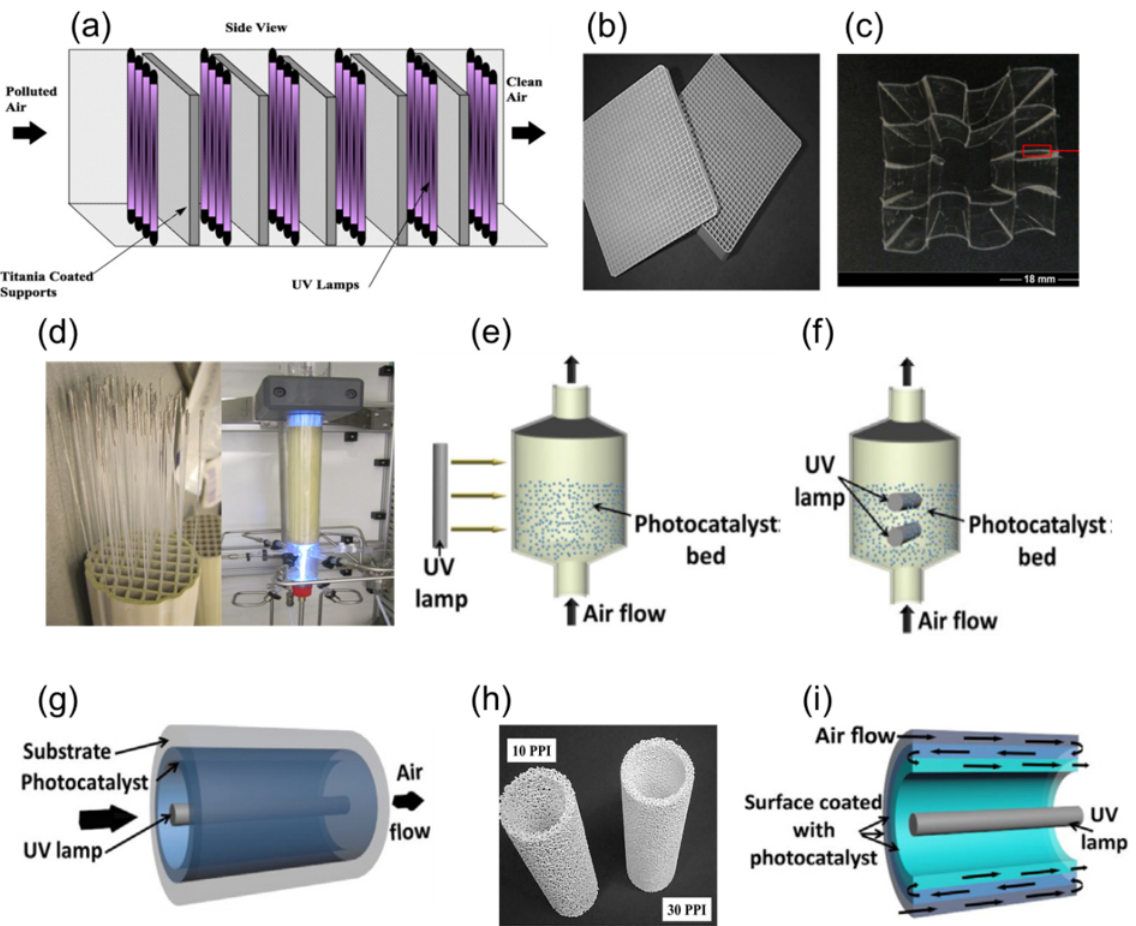
Figure 7. ( a ) Schematic representation of commercial-scale monolith-based reactor for air purification, reproduced with per- mission from reference [92]. ( b ) Square-channeled honeycomb monoliths, reproduced with permission from reference [130]. ( c ) TiO 2 -coated transparent monolith for air purification, reproduced with permission from reference [132]. ( d ) Photographs of monolith reactor equipped with light-emitting fibers inserted into the monoliths, for multiphase photocatalytic treat- ment, adapted with permission from [128]. ( e – f ) Fluidized bed photoreactor with external ( e ) and internal ( f ) irradiation, reproduced with permission from reference [127]. ( g ) Tubular flow photoreactor enclosing lamps with internal-wall-coated photocatalyst, reproduced with permission from reference [127]. ( h ) Alumina reticulated foam monoliths for the use in a photocatalytic tubular flow photoreactor, reproduced with permission from reference [130]. ( i ) Multi-walled tubular reactor flow photoreactor for enhanced mass transfer, reproduced with permission from reference